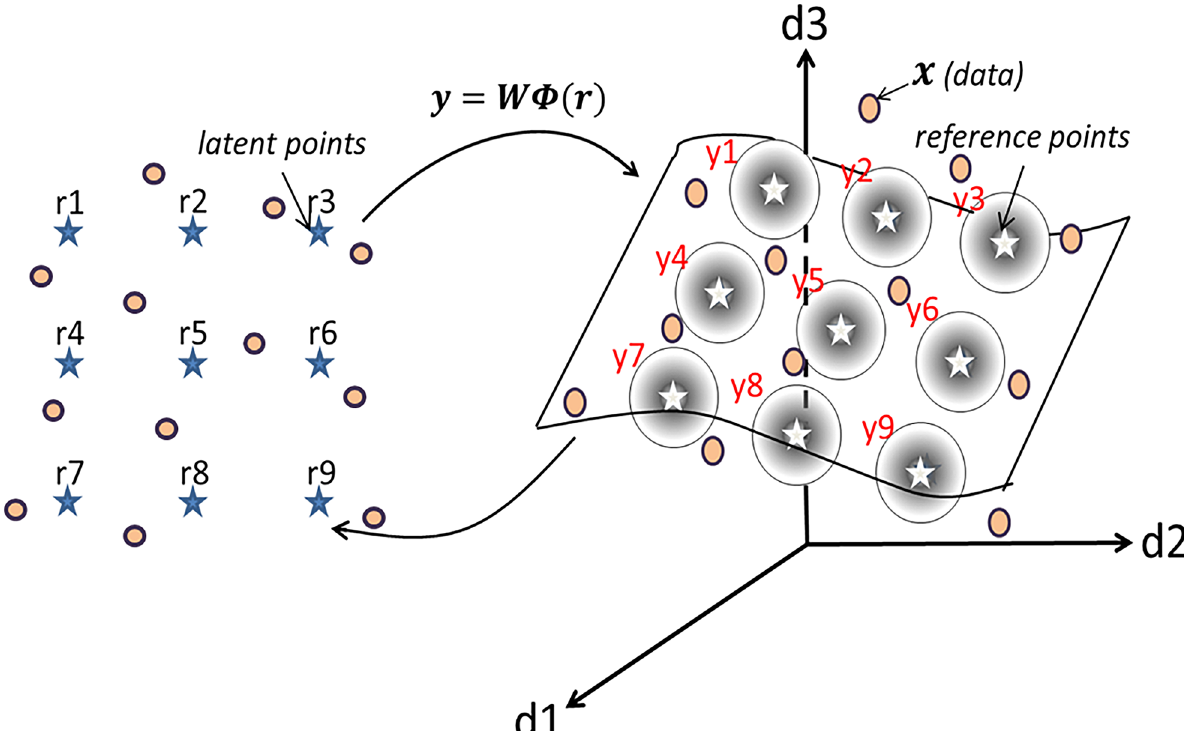
Fig 1. A visual description of GTM. This exemplifies how the latent space constructed by r (denoted by ? on the left) and the manifold constructed by y (denoted by ? on the right) in a three-dimensional data space relate. Raw data points x are denoted by (cid:129) .